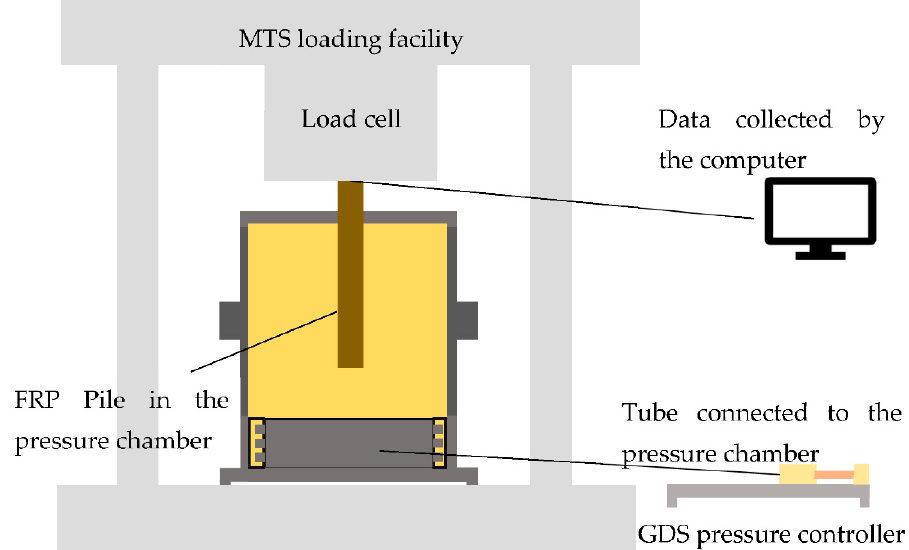
Figure 3. Profile of the pressure chamber tested under the axial load (not to scale).